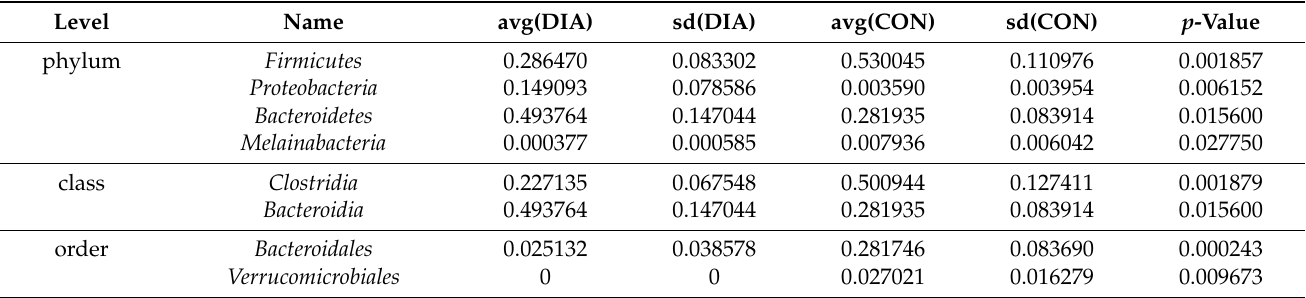
Table 3. T -test analysis of rabbit colon intestinal microflora in DIA group and CON group at phylum, class, order, family, and genus